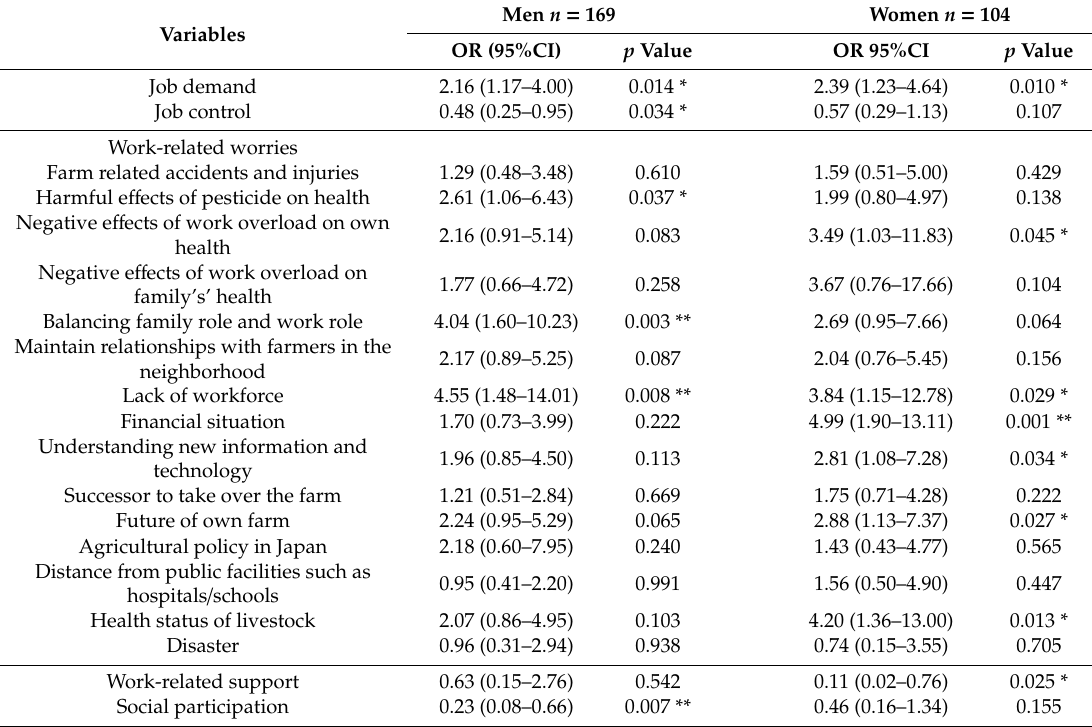
Table 4. Logistic regression analysis of work environment factors relating to depressive